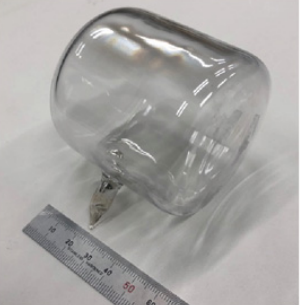
Figure 12. A first 3 He spin filter fabricated at J-PARC.